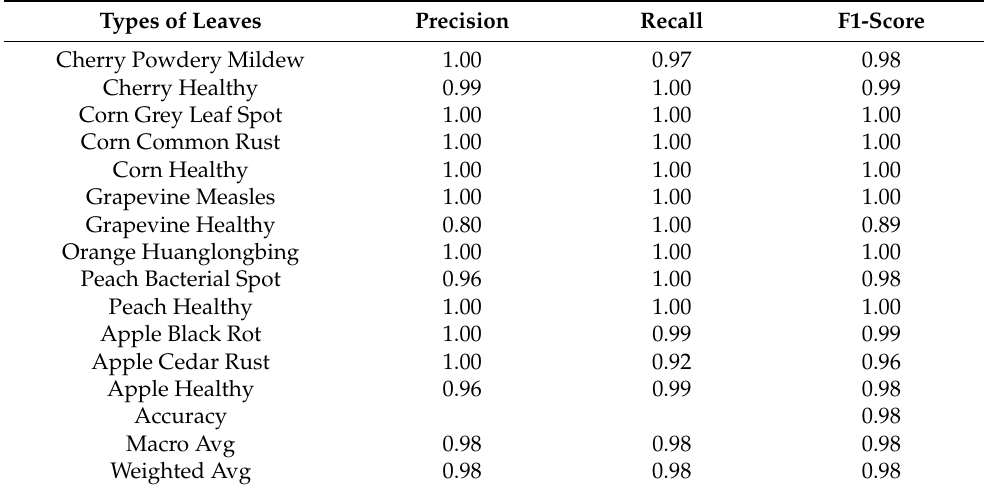
Table 4. Evaluation metric scores of Top-13 leaves.